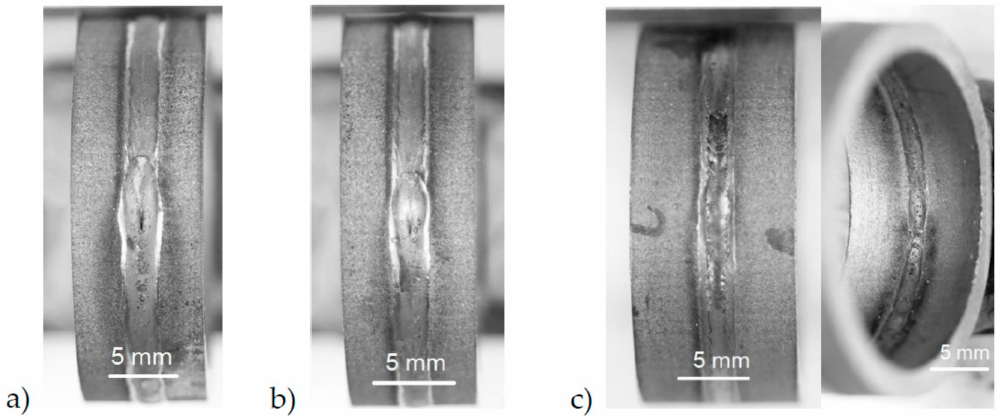
Figure 5. End crater outer appearance in overlap area at di ff erent process parameters: ( a ) P l 1700 W, v w 1.0 m / min, RP l 200 ms; ( b ) P l 1600 W, v w 1.0 m / min, RP l 200 ms; ( c ) P l 1600 W, v w 1.0 m / min, RP l 200 ms, scanner frequency (f) 100 Hz, and amplitude (A) 1